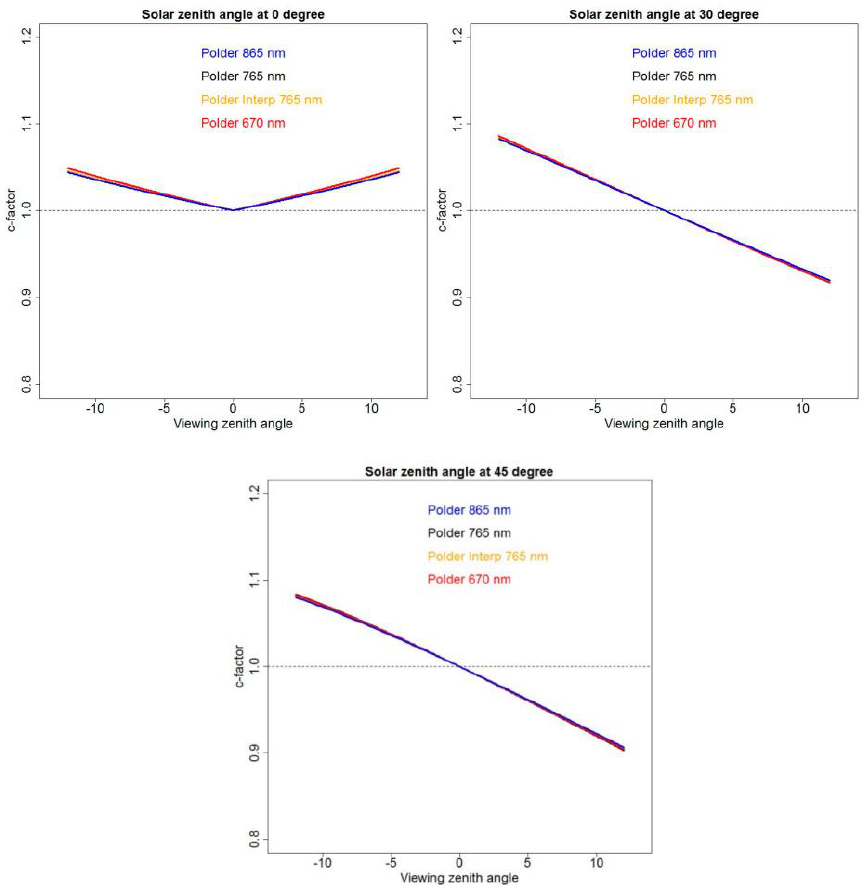
Figure 3. c -factors (derived as 2) using the fixed global annual POLDER NIR 865 nm (blue), red-edge 765 nm (black), and red 670 nm (red) BRDF model parameters (Table 2) and using the interpolated POLDER red-edge 765 nm (orange) BRDF model parameters. Shown for Sentinel-2 MSI ± 10.3° view zenith angle range and for three fixed solar zenith angles (0°, 30°, 45°). The orange and blue lines are almost identical and the blue lines are plotted over the orange lines.